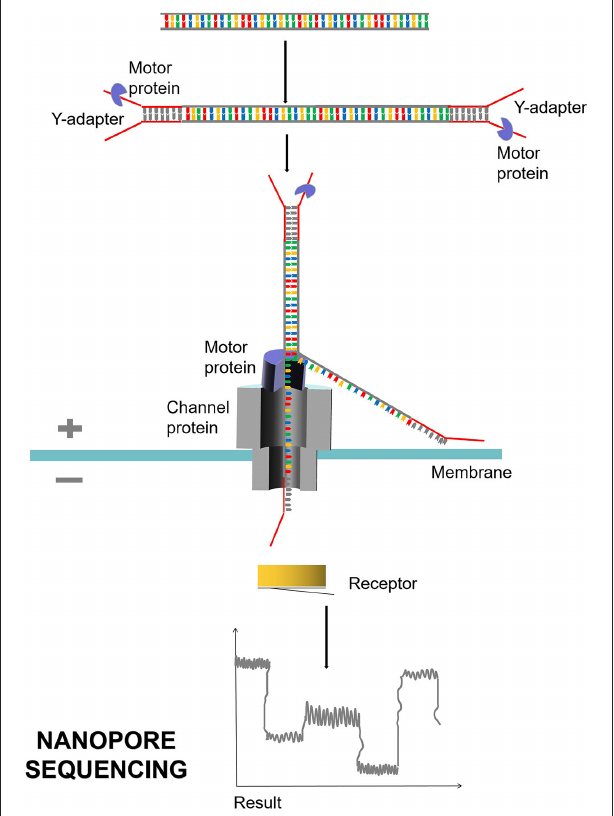
FIGURE 6 | Nanopore sequencing process. Nanopore sequencing mainly uses nanopore protein, also known as reader protein, which is a transmembrane channel protein. Different voltages are applied on both sides of the membrane. DNA double strand is decoiled under the traction of motor protein, and a single molecule is driven by electrophoresis to pass through reader protein one by one. Different electrical signals are produced and detected when the bases of ATCG pass